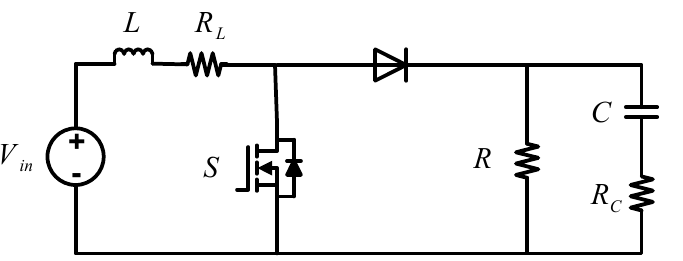
Figure 3. Boost converter considering parasitic components .